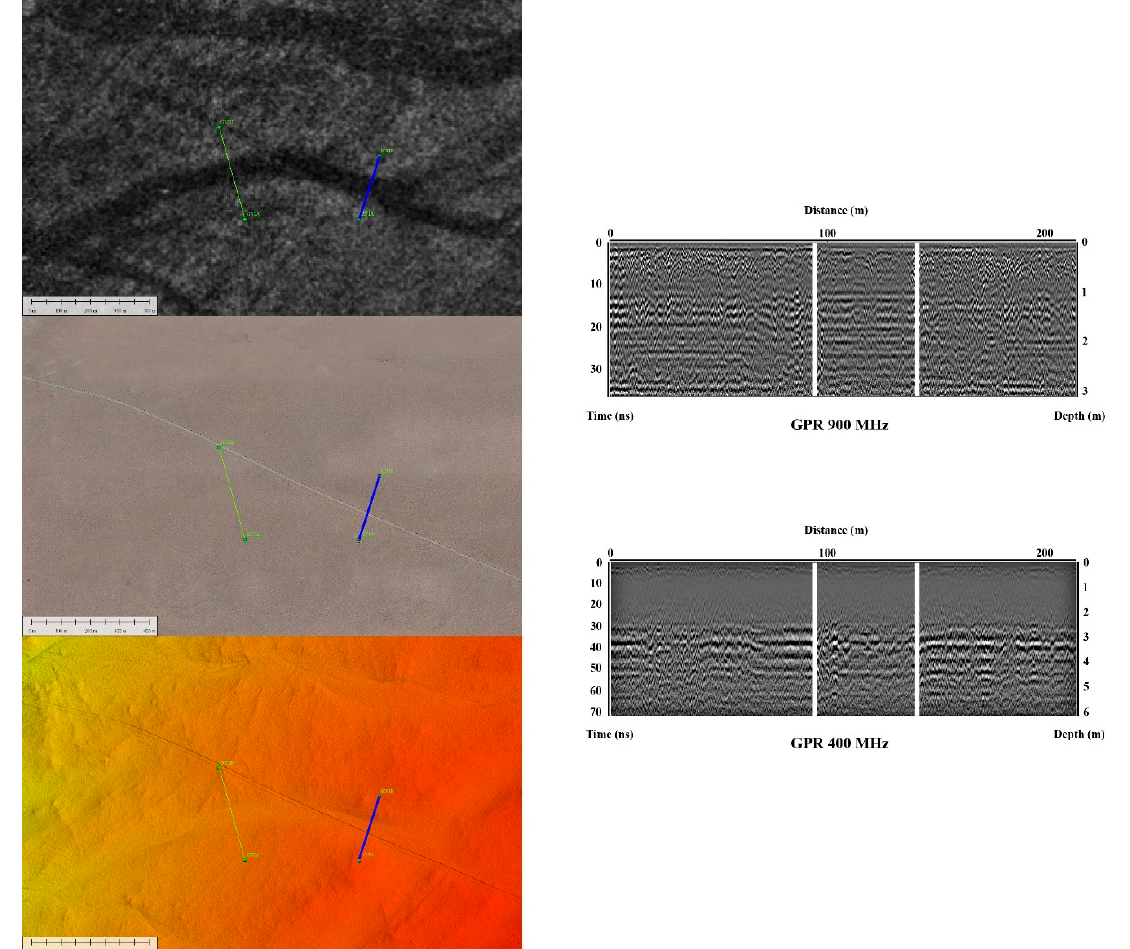
Figure 5. ( Left ): view of the Natab River test site with GPR profiles GN1 and GN2 (PALSAR-2 top, drone-generated mosaic middle, drone-generated DEM bottom). ( Right ): GN1 ground-penetrating profile acquired at 900 MHz ( top ) and 400 MHz ( bottom ). Depth scale was computed using a dielectric constant ε = 3; the buried channel is located between white vertical lines.